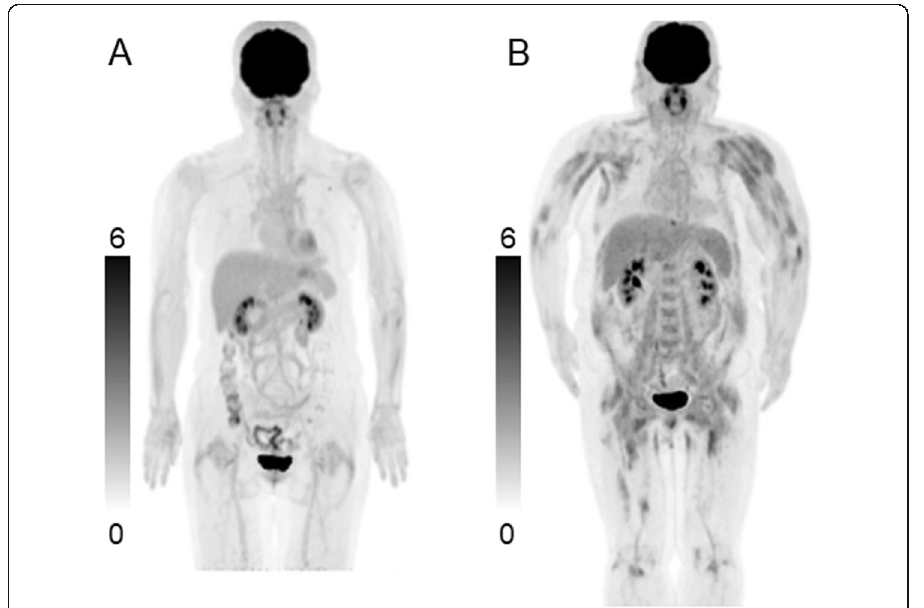
Fig. 1 18 F-FDG PET maximum intensity projection (MIP) image of a 58-year-old female as a control patient shows no increased uptake in the skeletal muscles ( a ). 18 F-FDG PET MIP image of a 53-year-old female with dermatomyositis shows diffuse uptake in the proximal skeletal muscles ( b